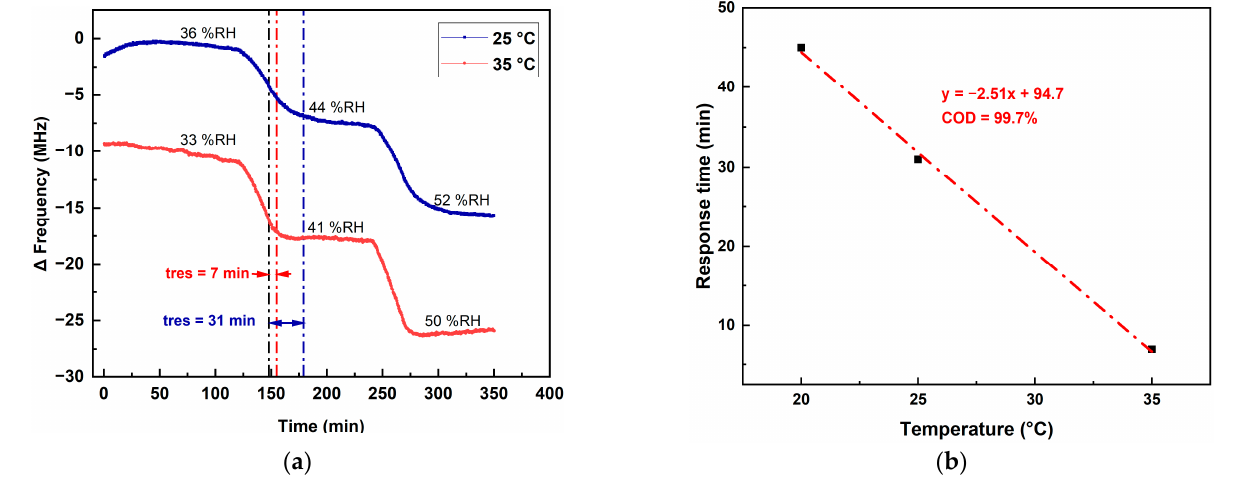
Figure 7. Effect of temperature on the sensor RH response: ( a ) dynamic frequency variation with steps of RH at 25 and 35 °C; ( b ) response time vs. temperature. steps of RH at 25 and 35 ◦ C; ( b ) response time vs.